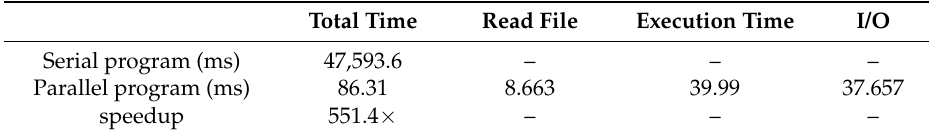
Figure 7. Schematic of electrically large sea surface discretized into triangular meshes. Table 1. Runtime and speedup for the graphics processing units (GPU)-based SDCSM program Table 1. Runtime and speedup for the graphics processing units (GPU) ‐ based SDCSM program compared with conventional serial C program. compared with conventional serial C program.